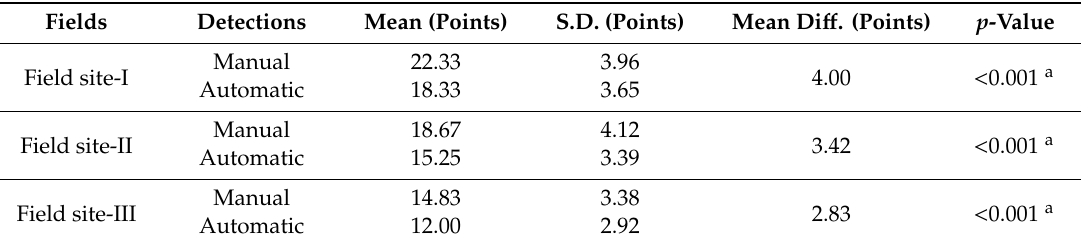
Table 6. Pair-wise t -test for manually and automatically powdery mildew disease detection.